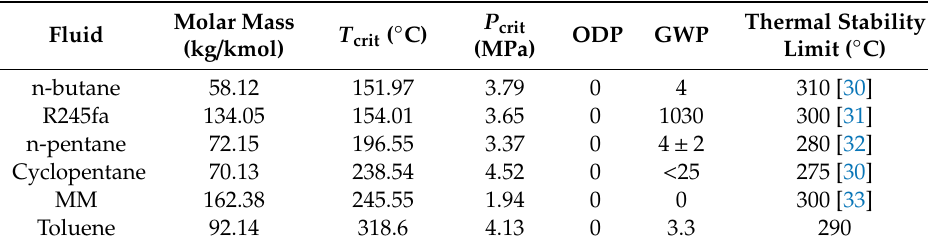
Table 4. Properties of the considered working